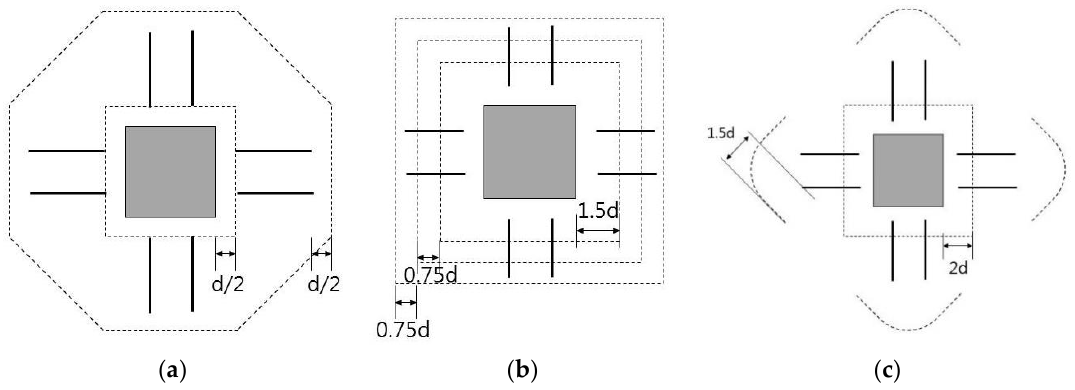
Figure 2. Critical sections provided by ACI 318-19, BS 8110 – 97 and Eurocode 2: ( a ) ACI 318 – 19; ( b ) BS 8110 – 97; ( c ) Eurocode 2.